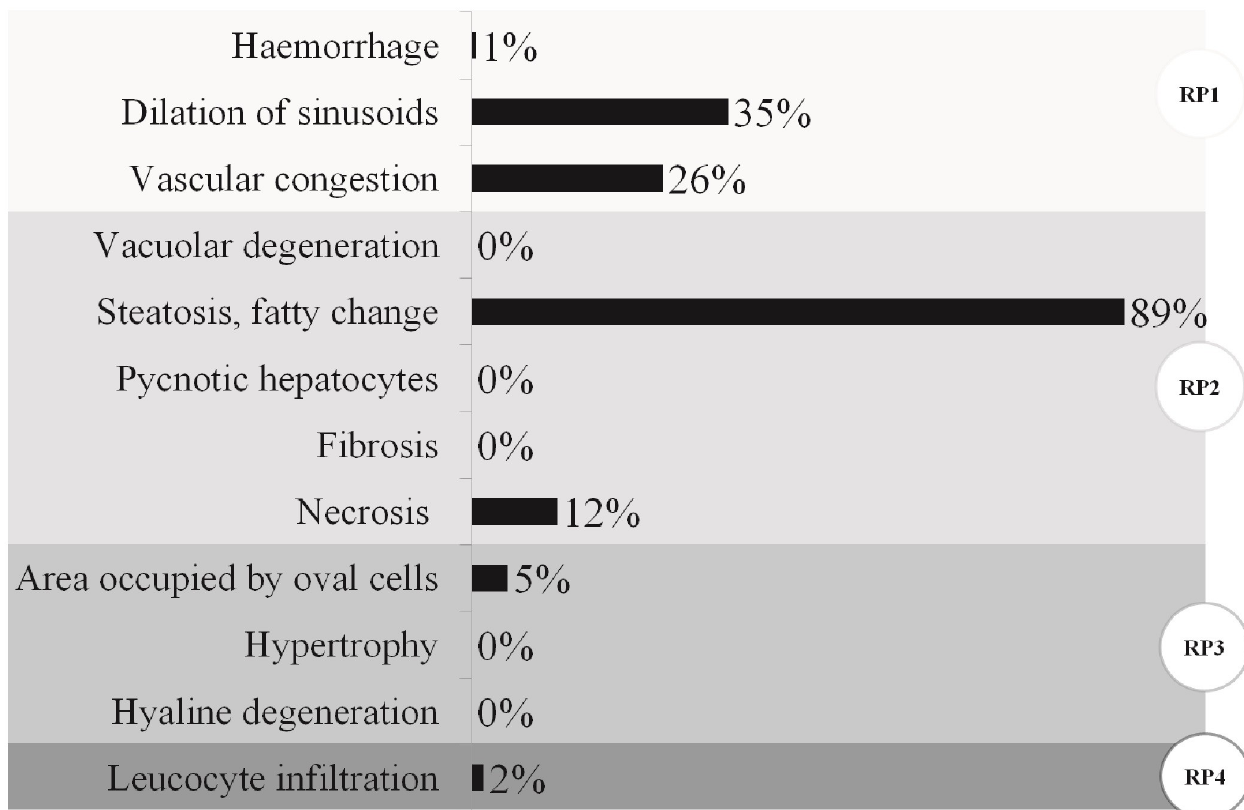
Fig 8. Frequency of histopathological alterations registered in all livers analyzed. The reaction pattern (RP) to which the alterations correspond is indicated with different intensity of gray and a circular label: RP1 (circulatory disturbances), RP2 (regressive changes), RP3 (progressive changes), RP4 (inflammation) (n = 5; N = 45, only 5 birds from the basal diet were studied).